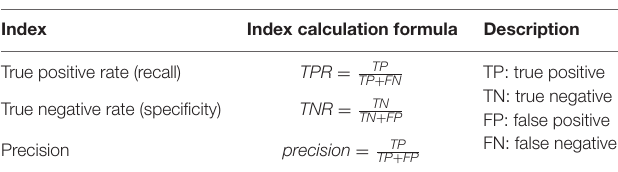
TABLE 4 | Evaluation indicators.